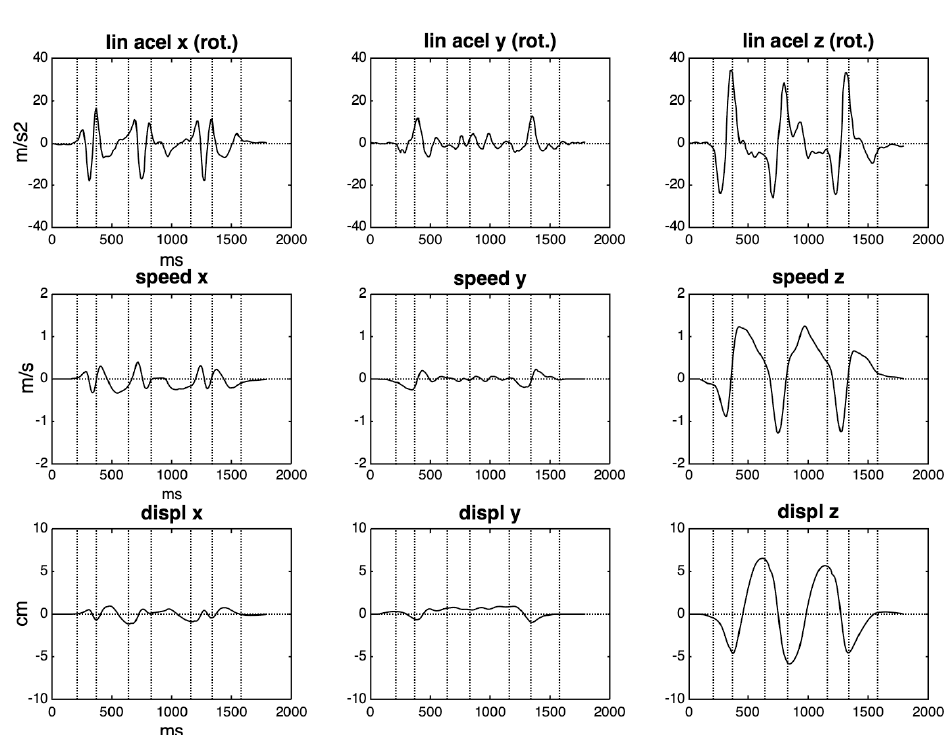
Figure 7. In the first row, curves of 3D acceleration rotated to the IMU frame of reference. The following rows depict the speed and displacement curves that were obtained by